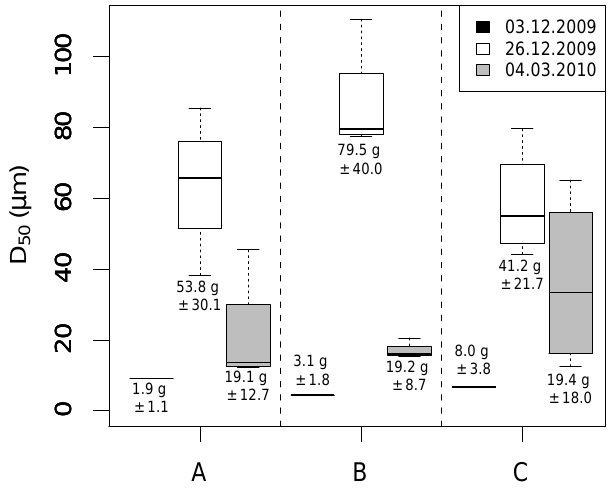
Fig. 5. Weekly D 50 of the suspended sediment (SS) caught by the SS samplers ( n =6/site) during three weeks at the three sites A, B and C. Mean total amount of SS load ± standard deviation is given below/above the boxes. The 6 samples of 3 December 2009 had to be merged for grain size analysis because of the small quantity of